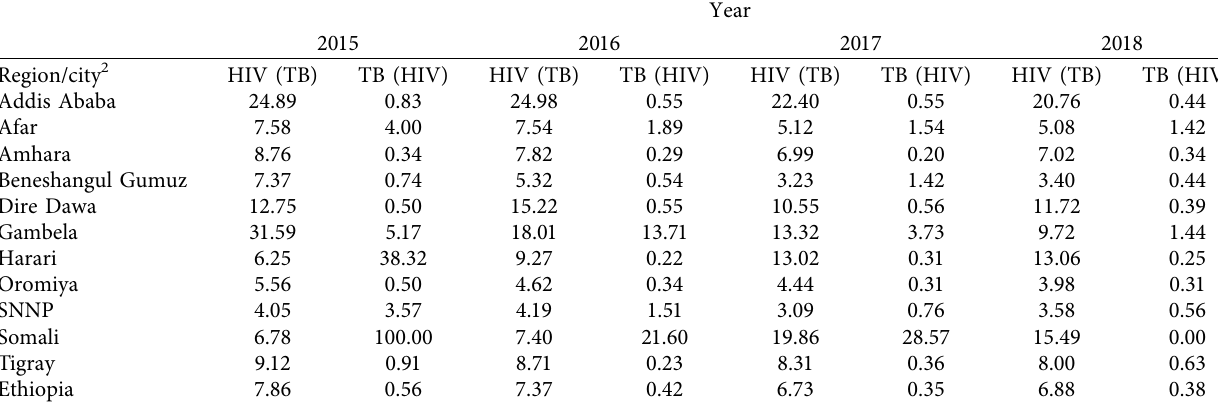
Table 2: Te prevalence of HIV among TB patients (HIV(TB)) and the prevalence of TB among HIV patients (TB(HIV)) by year in all regions and of